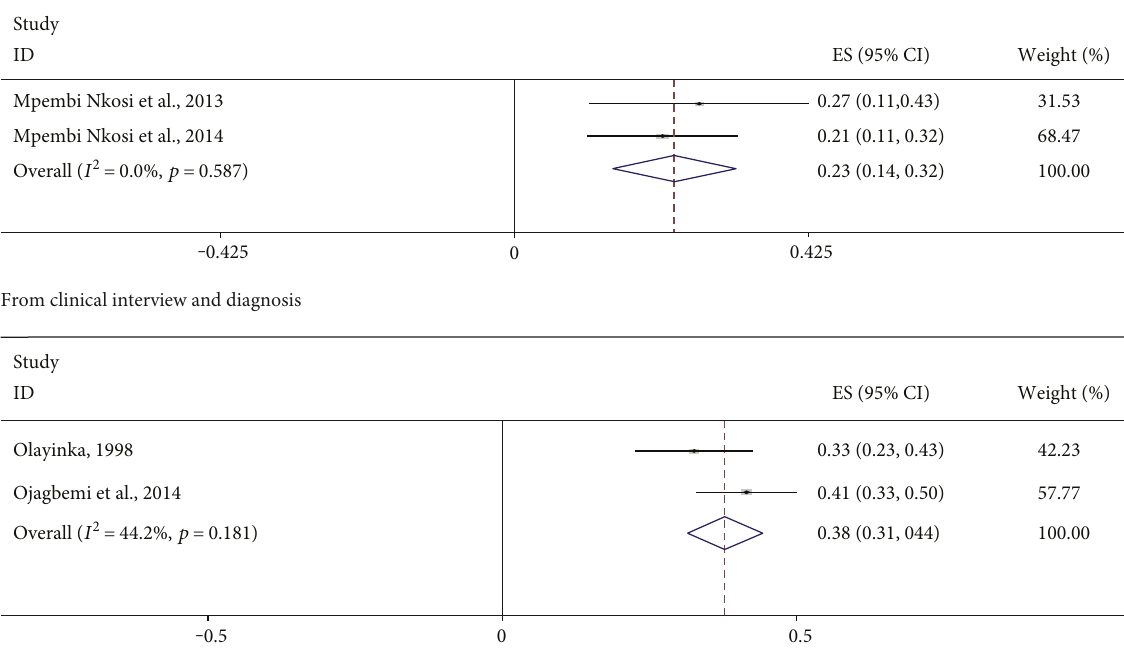
Figure 4: Forest plots showing the pooled prevalence of poststroke depression in the rehabilitation